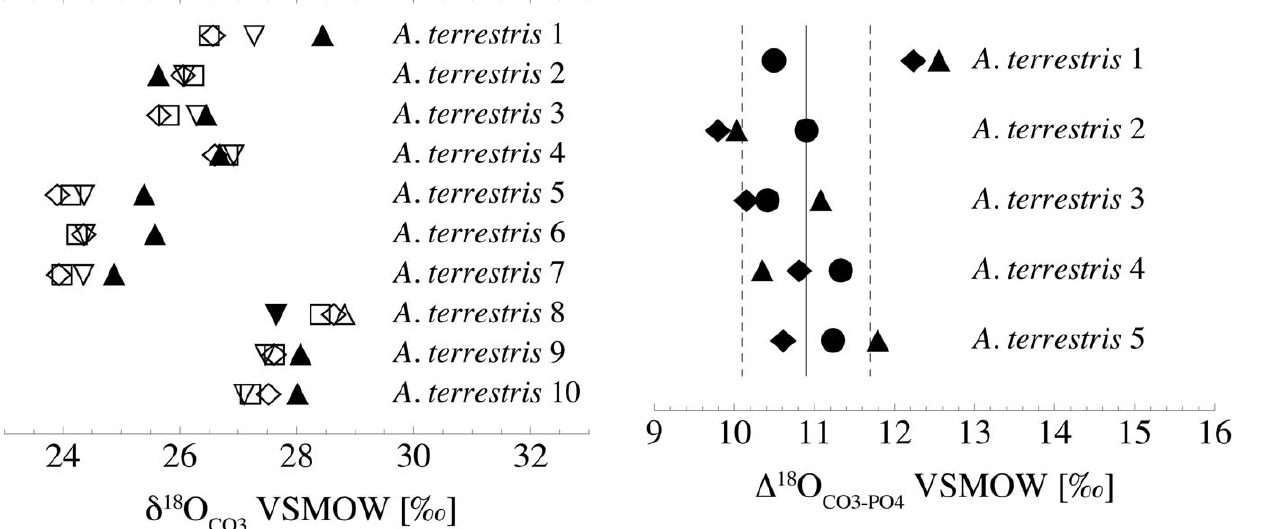
Figure 6. Intra-jaw variations in d 18 O CO3 of Arvicolaterrestris . Filled triangles=incisors, open diamonds=M1, open squares=M2, open down triangles=M3.